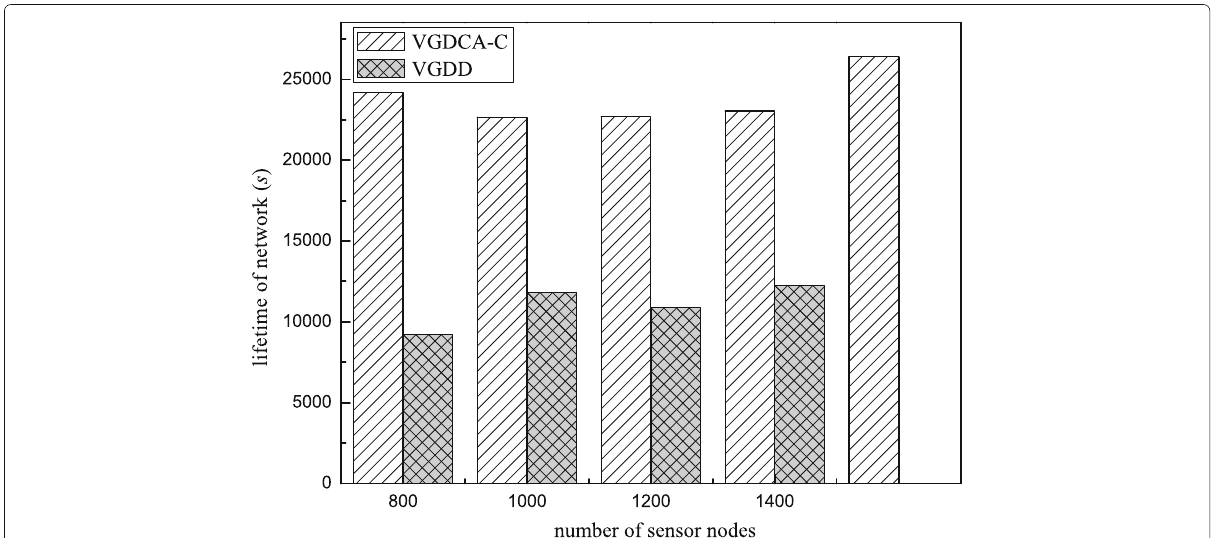
Fig. 12 The comparison of VGDD and VGDCA-C in network lifetime. It shows that network lifetime of the VGDCA-C was longer that VGDD in our simulation model